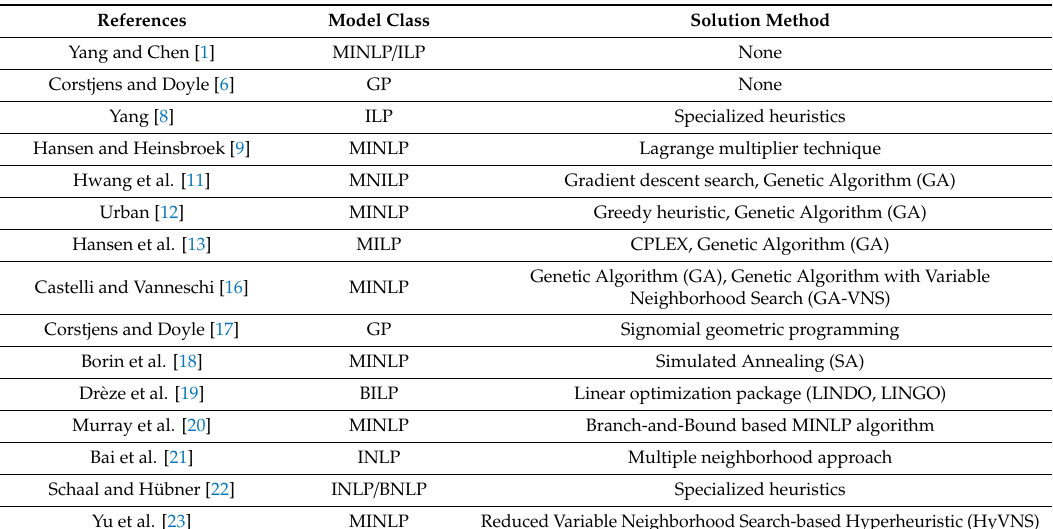
Table 1. Model classes and solution methods of related